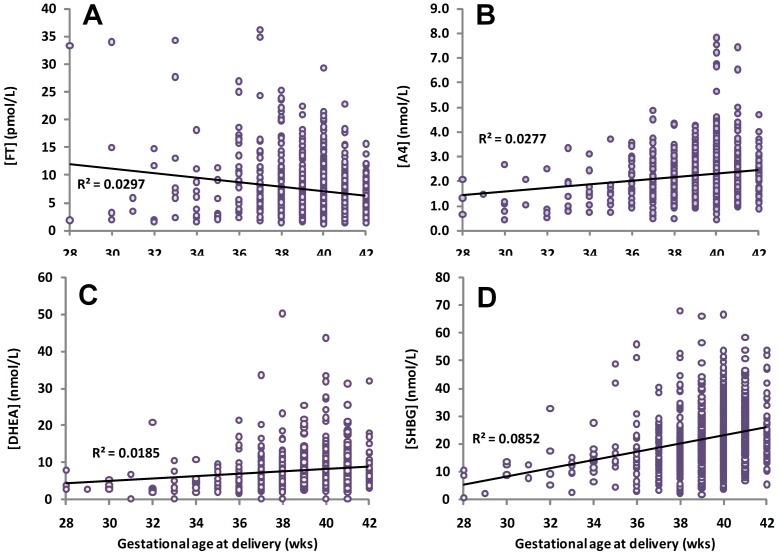
Linear regression analysis of the relationships between gestational age at delivery and cord blood androgen and SHBG concentrations in 803 neonates (males and females combined).The linear regression coefficients (R2) are indicated on each graph. All correlations remained statistically significant (P<0.0001) after controlling for obstetric factors.